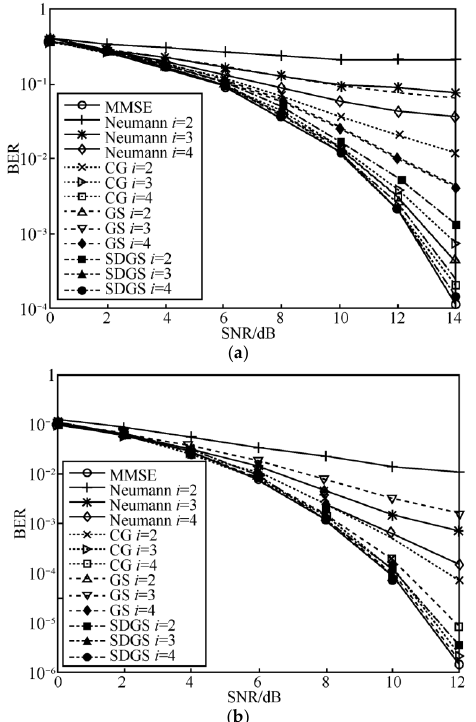
Figure 2. Hard decision bit error rate (BER) performance comparison. ( a ) Analysis at 64 × 16 antenna configuration; ( b ) Analysis at 128 × 16 antenna configuration.